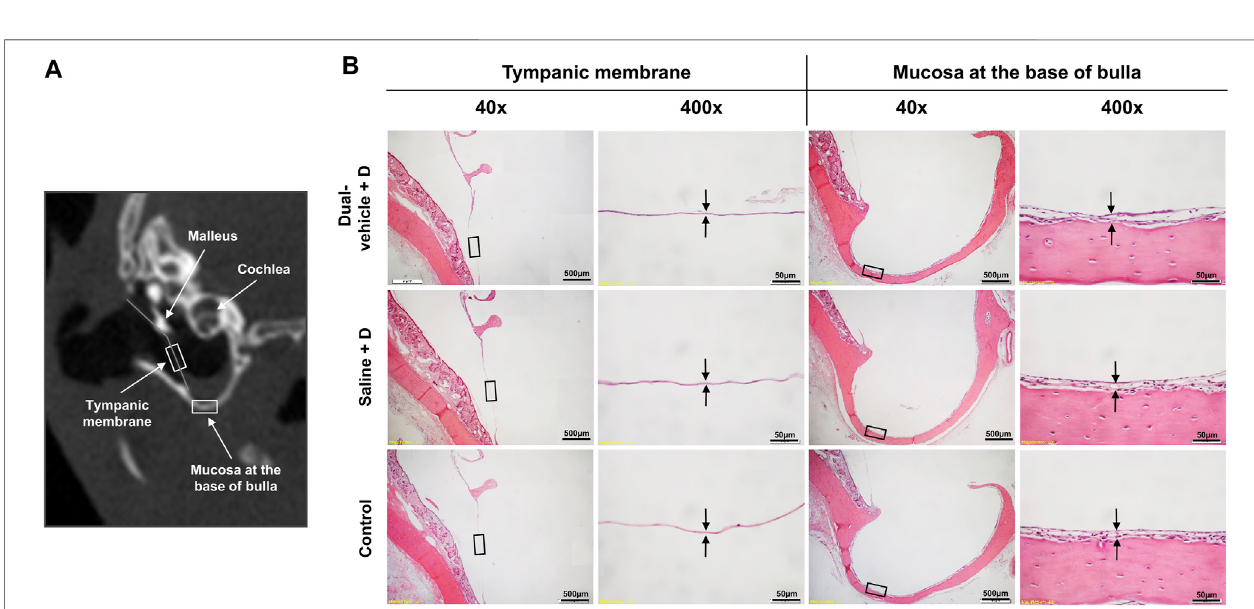
FIGURE 6 | Histology of the tympanic membrane (TM) and mucosa at the base of the bulla (BB). (A) The two most vulnerable anatomic locations, the TM and BB, were evaluated histologically for evidence of in fl ammation or infection. (B) The samples were stained with hematoxylin and eosin. There were no differences in the qualitative morphology or quantitative thickness of the TM or BB mucosa among the three groups.